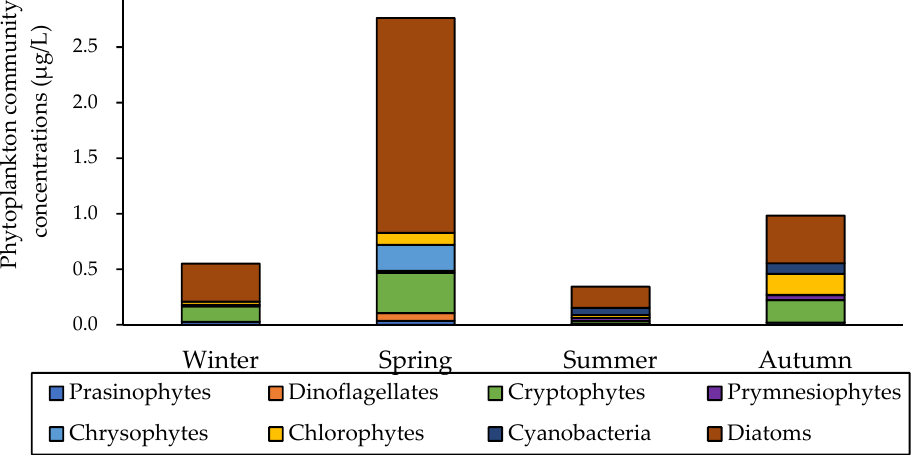
Figure 2. Phytoplankton community concentrations ( µ g/L) in the YS during the study period in 2019.